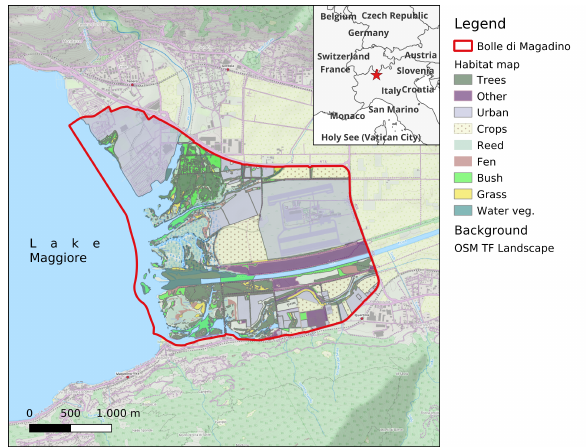
Figure 1. Location of the study area “Bolle di Magadino” (Switzerland) and habitat map. Background map: maps © www.thunderforest.com , data © OpenStreetMap contributors https://www.openstreetmap.org . World borders in the inlet map: